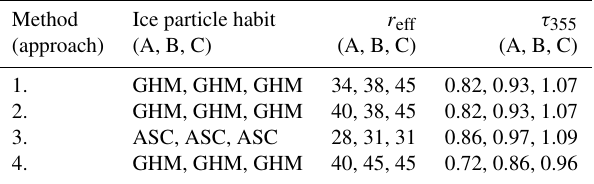
Table 3. Summary of the cloud optical properties that yield the clos- est agreement between the simulated and observed spectra for the four different minimization